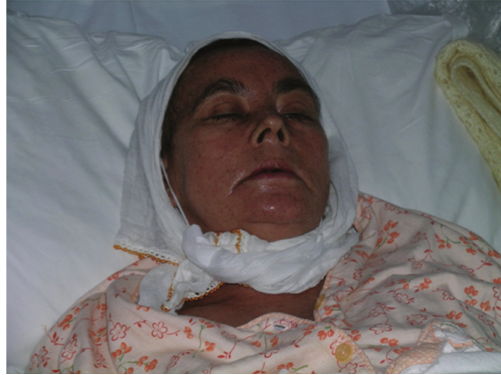
Figure 2: Widespread facial erythema.